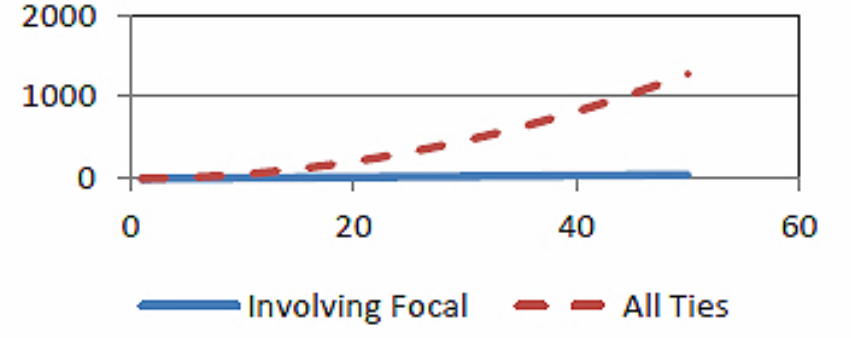
Figure 3. Comparison between the number of ties involving and not involving the focal